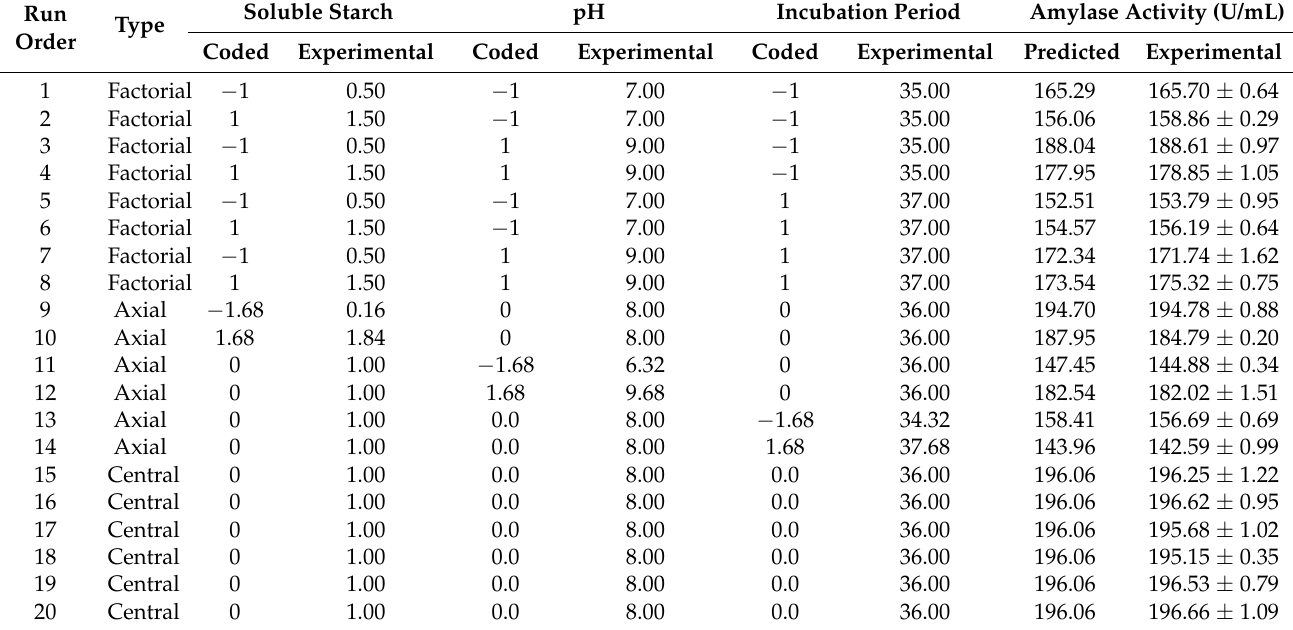
Table 4. Experimental data obtained for significant variables obtained from PBD in